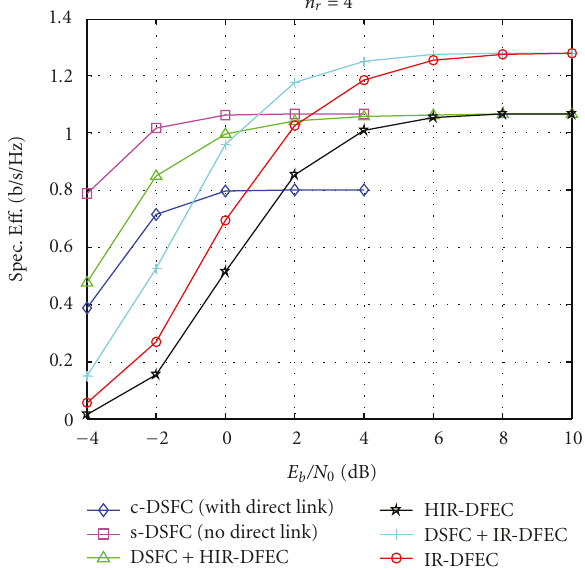
Figure 13: Spectral e ffi ciency versus E b /N 0-direct —modified D2— n d = 2, n r = 4.